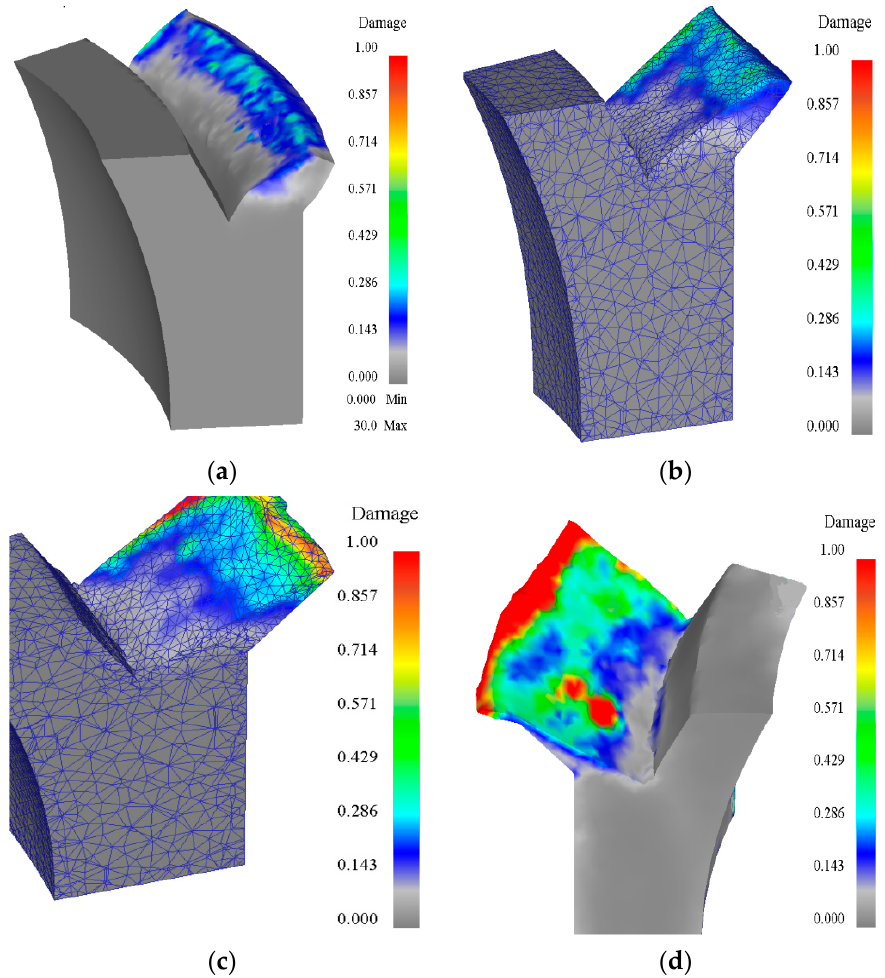
Figure 7. Damage degree of the flanging lip in the latter four states: ( a ) Material damage in “State 2”; ( b ) Material damage in “State 3”; ( c ) Material damage in “State 4”; ( d ) Material damage in “State 5”.